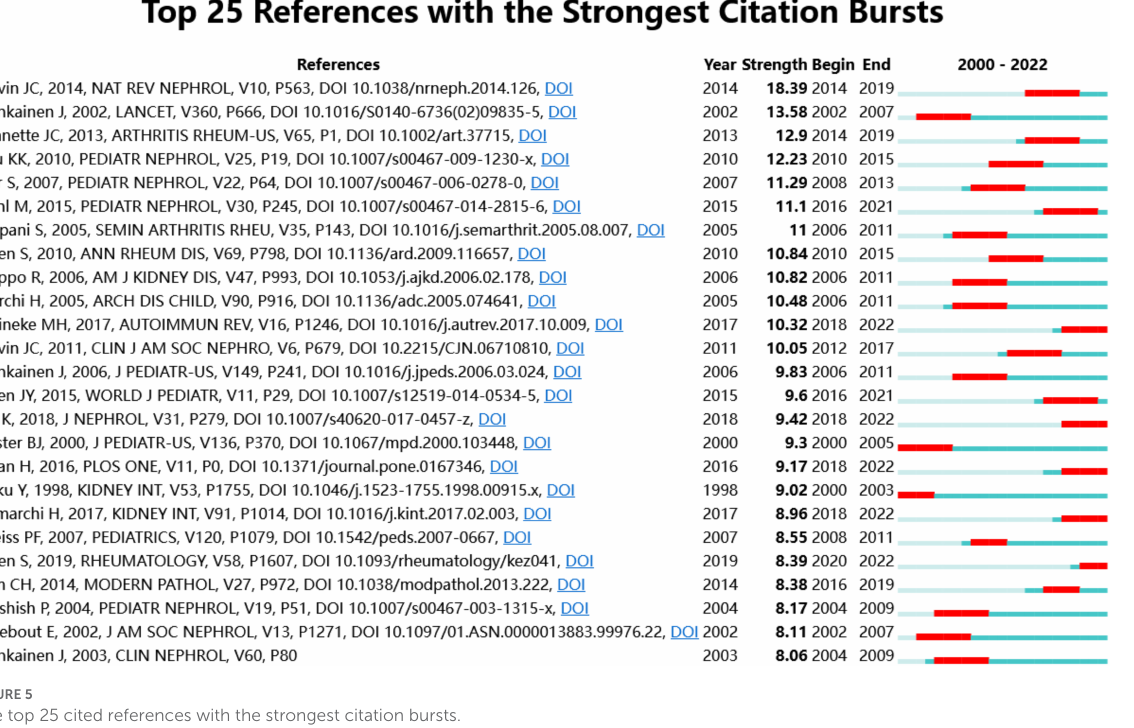
FIGURE5 The top 25 cited references with the strongest citation